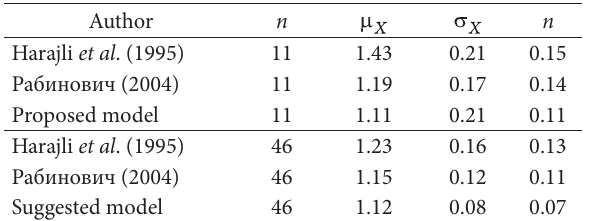
Table 4. Experimental results related to theoretical ones for slabs with steel fibres